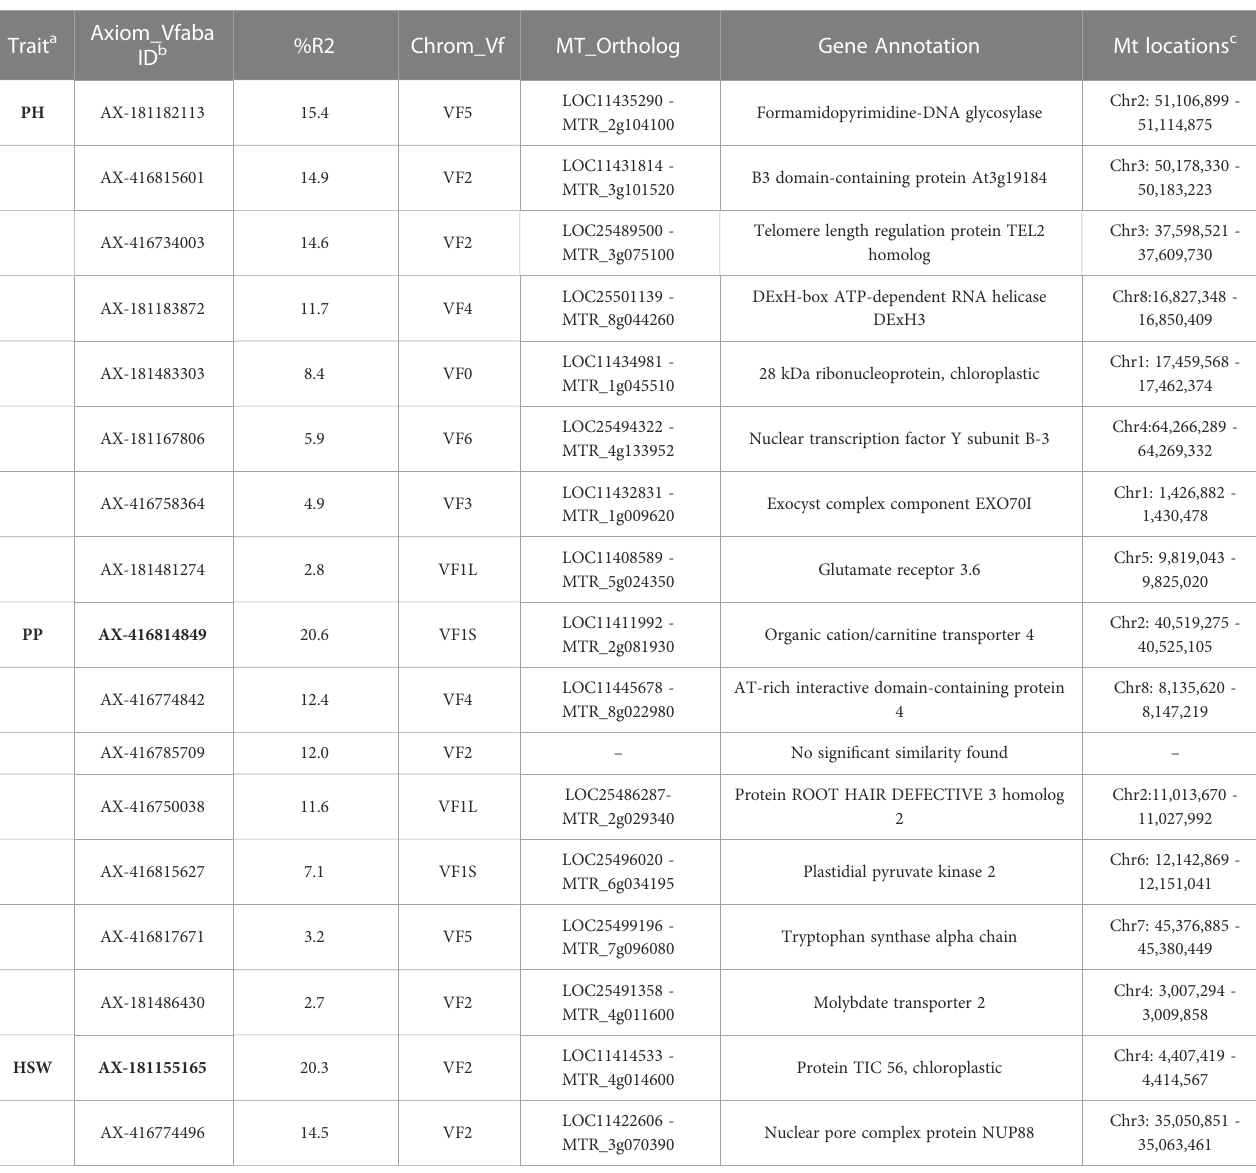
Under control conditions we detected 52 signi fi cant SNPs spread along the genome, although 17 did not reach the Bonferroni threshold -log10(p) > 5.83. Most of the signi fi cant markers, however, clustered in chromosome 1 and 2 (Table 2). Eight loci were associated with PH, PP, PY and SPAD1, accounting together for 70.5%, 64.9%, 84% and Gene Annotation Mt locations